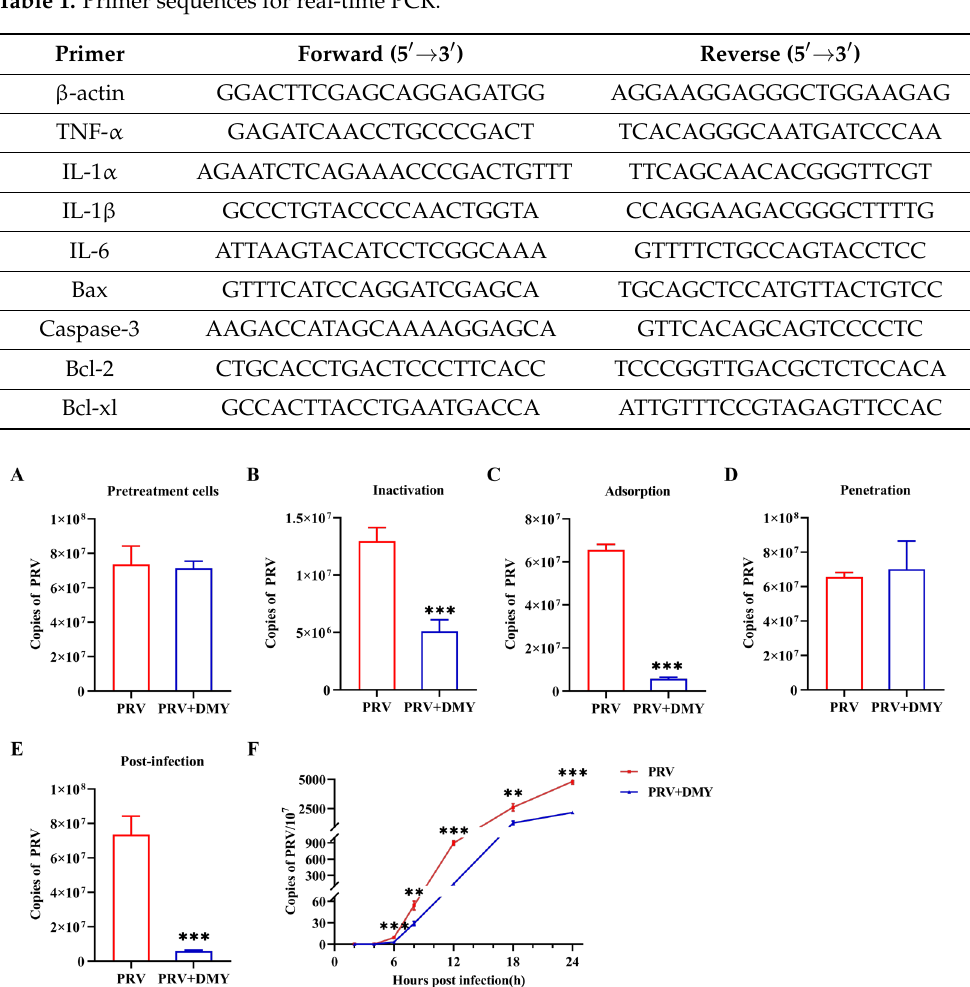
Figure 2. DMY’s mechanism of action against PRV. ( A ) The pretreatment effect of DMY against PRV. ( B ) The viral inactivation effect of DMY. ( C ) The inhibitory effect of DMY on the viral adsorption process. ( D ) Inhibition of PRV penetration by DMY. ( E ) Inhibition of DMY against PRV intracellular replication. ( F ) PRV growth curve. Viral DNA copy number at each stage was detected by FQ-PCR. PRV, virus-inoculated group; PRV + DMY, virus-inoculated and treated group, the concentration of DMY was 500 µ M. Compared with the PRV group, symbols *, ** and *** denote p < 0.05, p < 0.01 and p < 0.001, respectively. Table 2. Anti-PRV activity of dihydromyricetin.